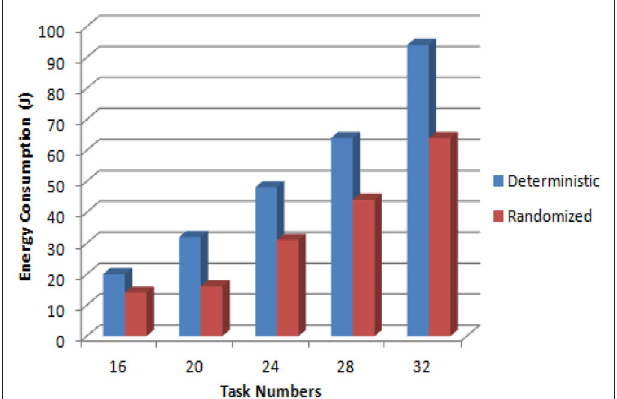
FIGURE 6 | Effect of mutation types.